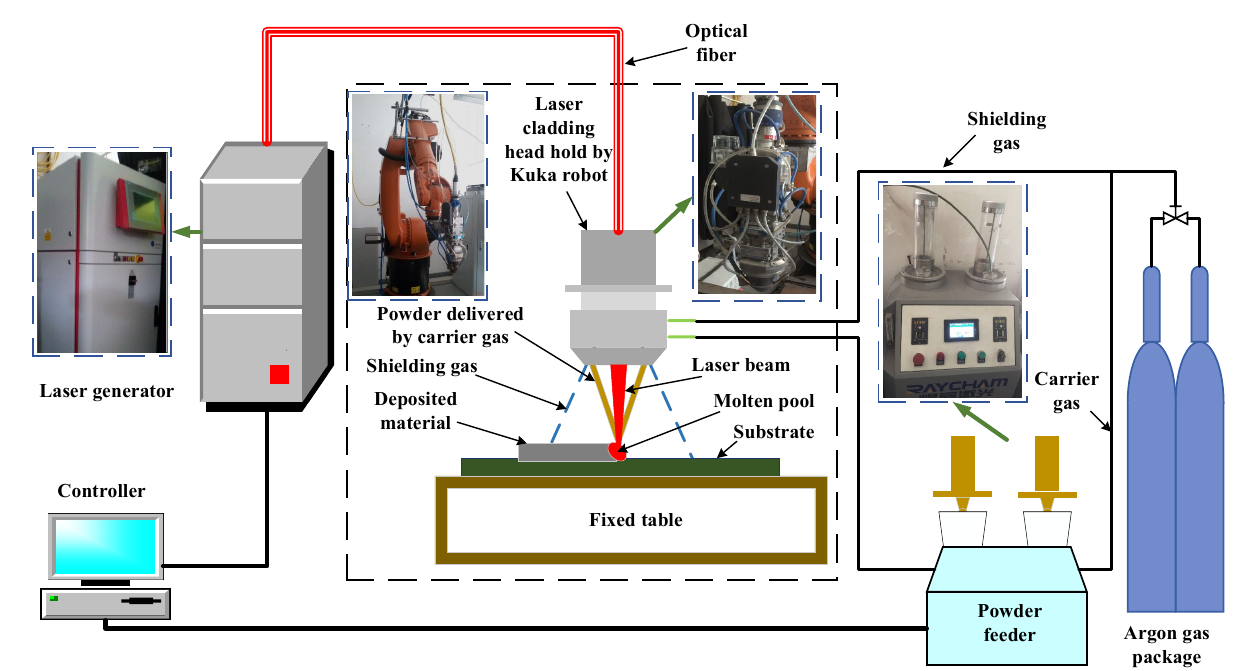
Figure 1. Schematic illustration of the laser material deposition (LMD) system.